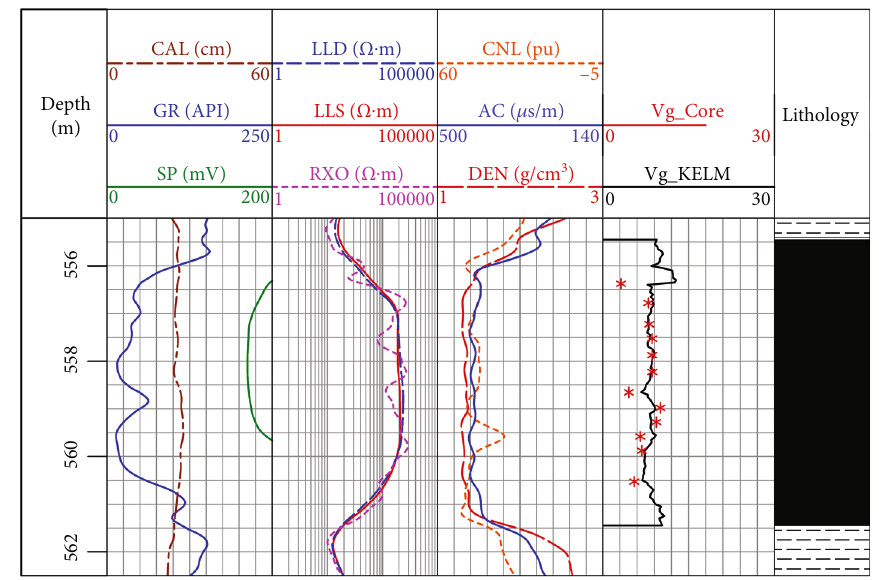
Figure 16: Evaluation results of CBM content of well A1.